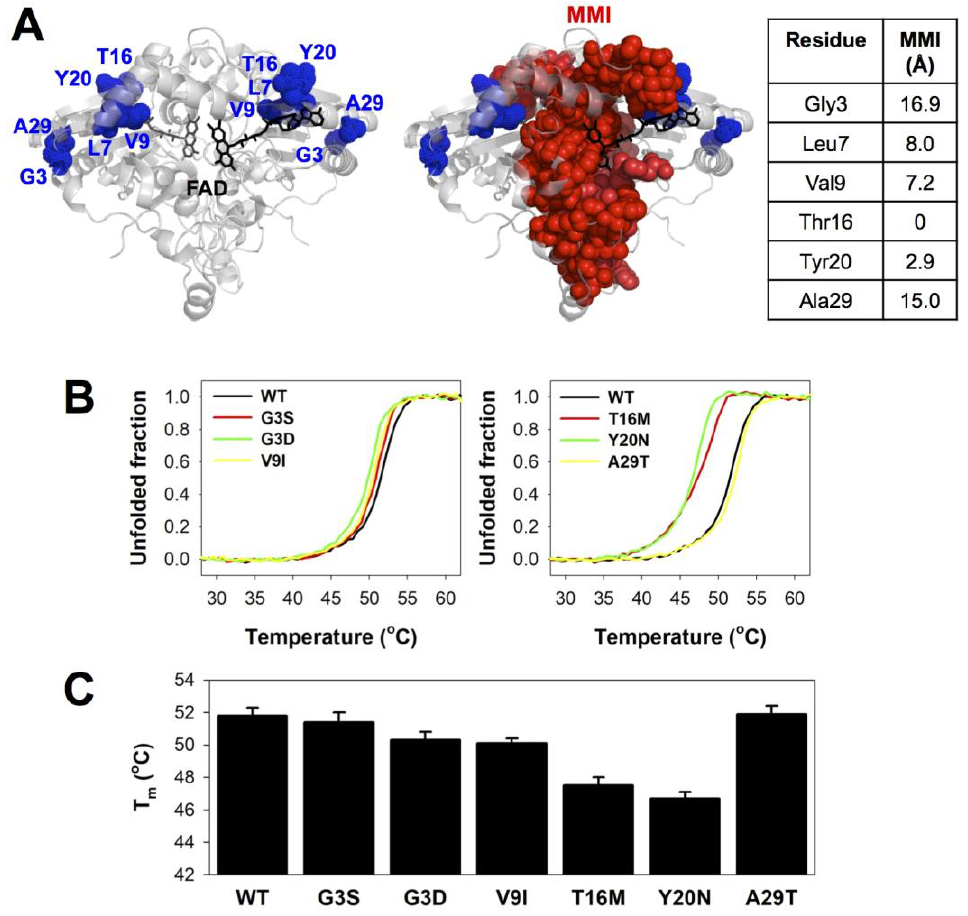
Figure 3. Thermal stability of NQO1 variants. ( A ) Structural location of the mutated residues, showing their proximity (as a minimal distance) to the monomer:monomer interface (MMI). The structure used for display has the PDB code 2F1O [72]. Residues belonging to the MMI were identified as described [90]. ( B ) Thermal denaturation profiles; ( C ) T m values (mean ± s.d. from six replicas, using proteins from two purifications).